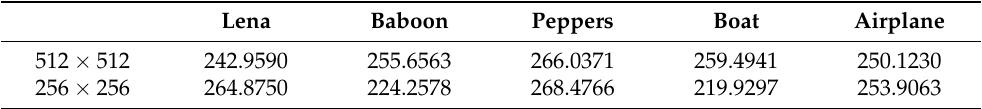
Table 9. Chi-square test.